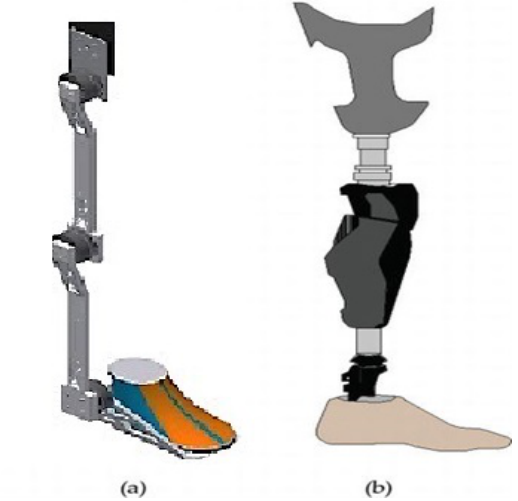
Figure 1. ( a ) Lower limb orthotic exoskeleton, ( b ) lower limb prosthetic robot